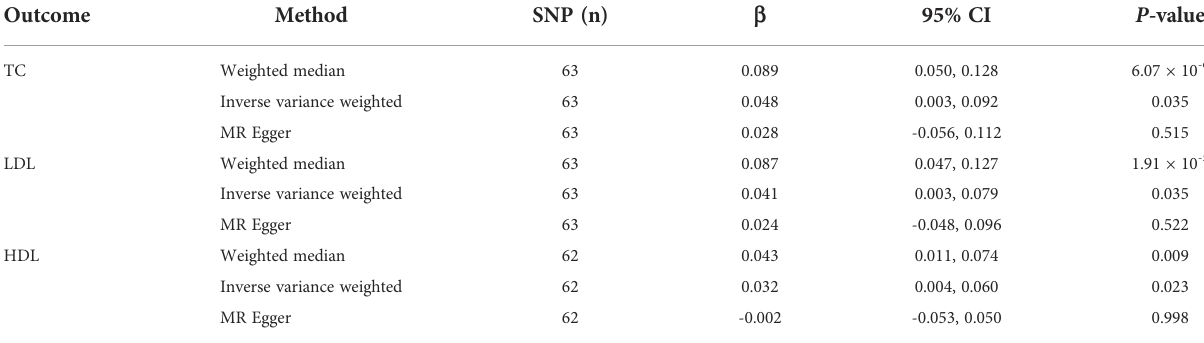
TABLE 1 The Mendelian randomization (MR) analysis results with regard to causal effect of AS on TC, LDL, and HDL levels.